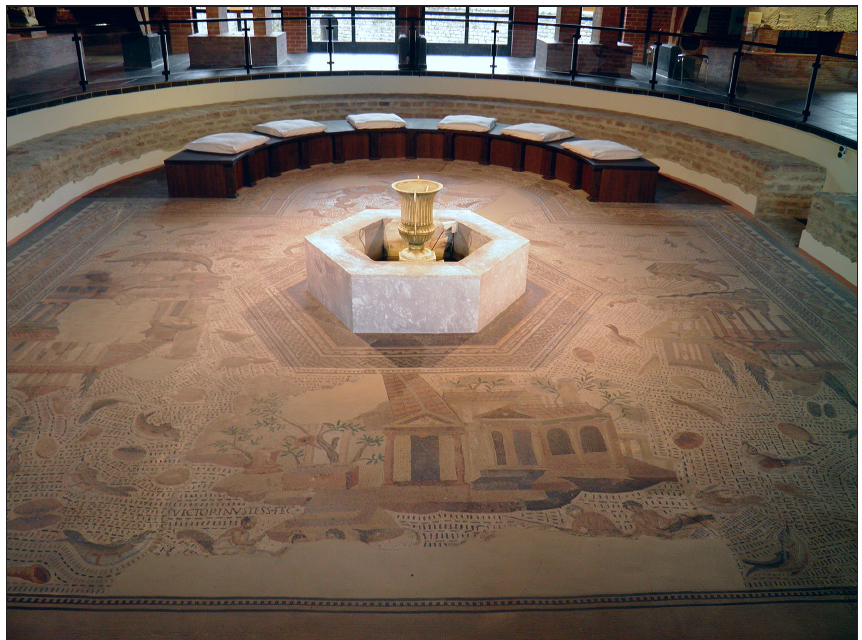
Figure 10: The Oceanus mosaic at Bad Kreuznach in context. (Photo: Carole Raddato, licensed under Creative Commons Attribution-Share Alike 2.0 Generic License).